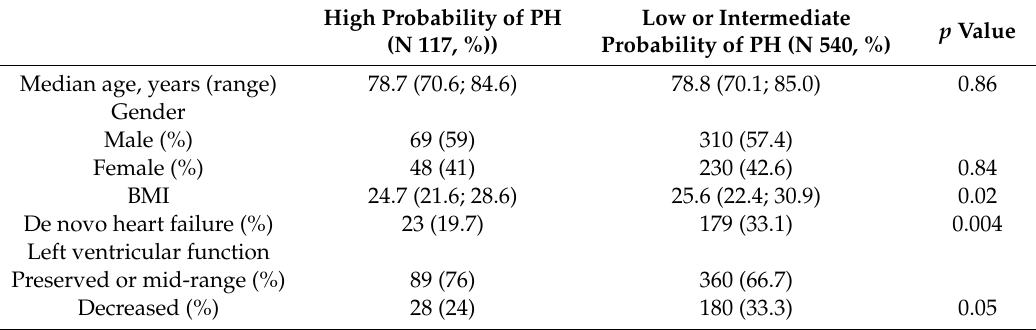
Baseline patient characteristics by echocardiographic probability of pulmonary hypertension